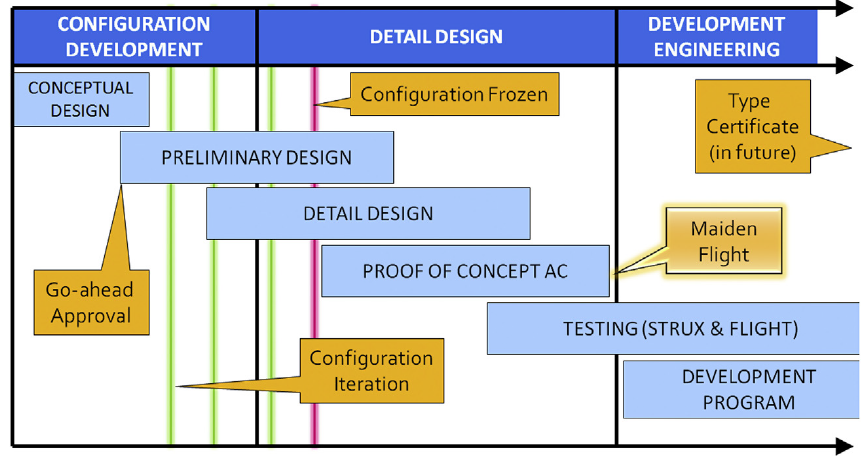
Figure 1. Aircraft design process for a typical GA aircraft. Reprinted from Ref